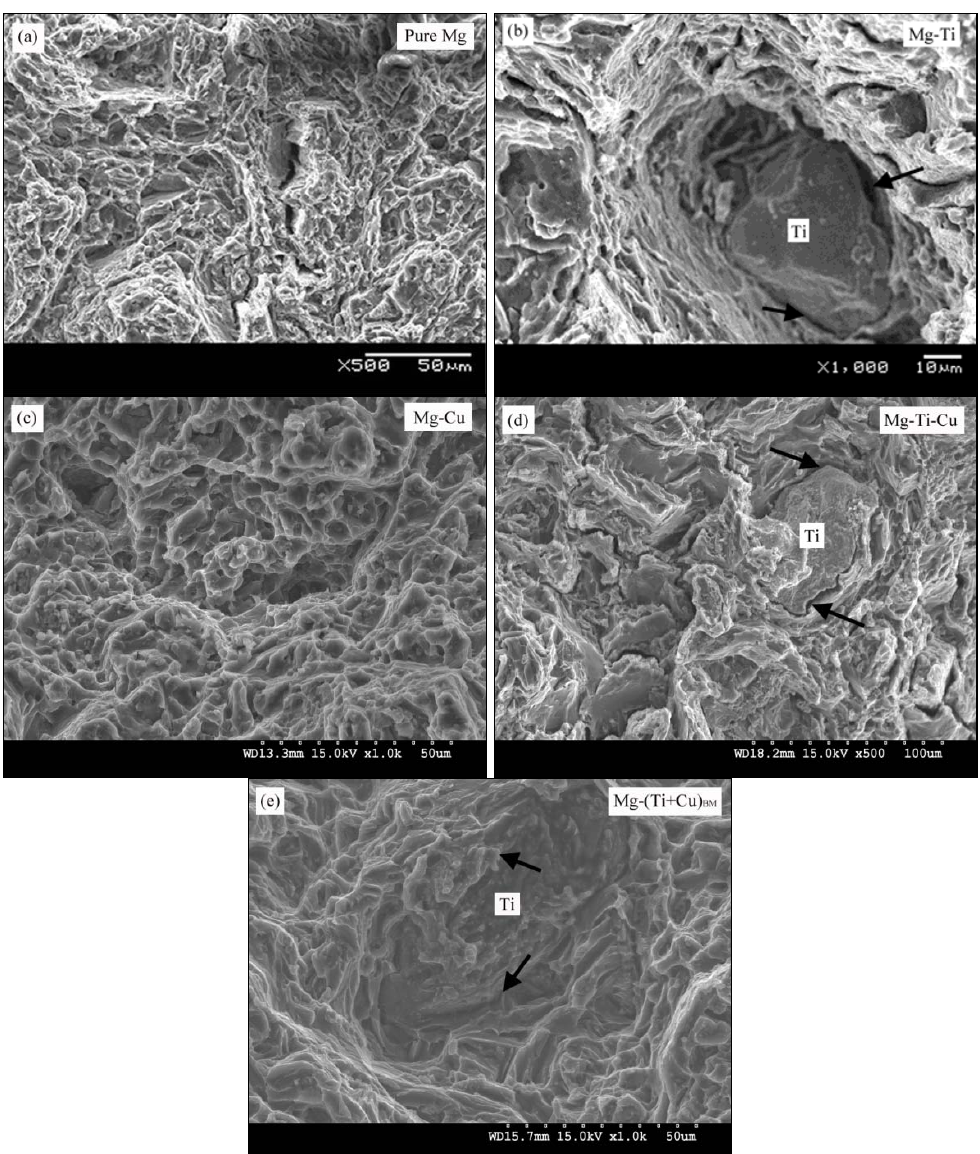
Figure 6. Fractographs of Mg-based materials after tensile loading showing: ( a ) Dominant cleavage fracture in pure Mg; ( b ) particle debonding in Mg-Ti; ( c ) cleavage fracture with ductile features in Mg-Cu; ( d ) dominant particle debonding features in Mg-Ti-Cu and ( e ) mixed fracture mode with good interface bonding with plastic deformation in Mg-(Ti + Cu) BM